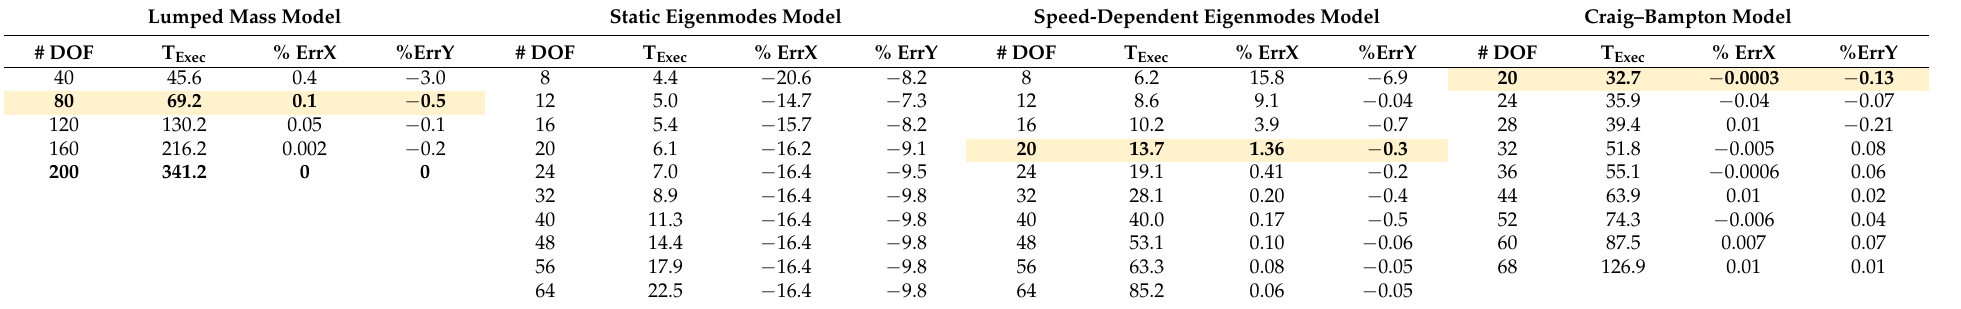
Table A1. Performance metrics of the different modeling methods for computing the maximum horizontal force (%ErrX) and vertical force (%ErrY) in the second bearing. # DOF is the number of degrees of freedom in the models: four times the number of lumped elements for the lumped mass model and number of modes for the other three models. T Exec is the execution time in seconds for a 100 s simulation time. %ErrX and %ErrY are the errors of the predicted forces relative to the lumped mass model simulation with 200 DOFs (50 nodes), the reference result. The bold highlighted results are the simulation for each method with the highest computational efficiency that converges within 2% of the reference result. For further reference, the execution time is 0.08 s when shaft flexibility is